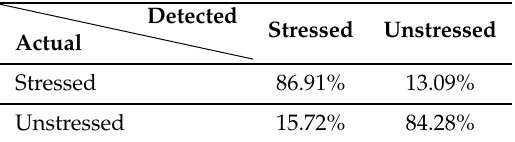
Table 3. Confusion matrix of TSDNet in stress detection.